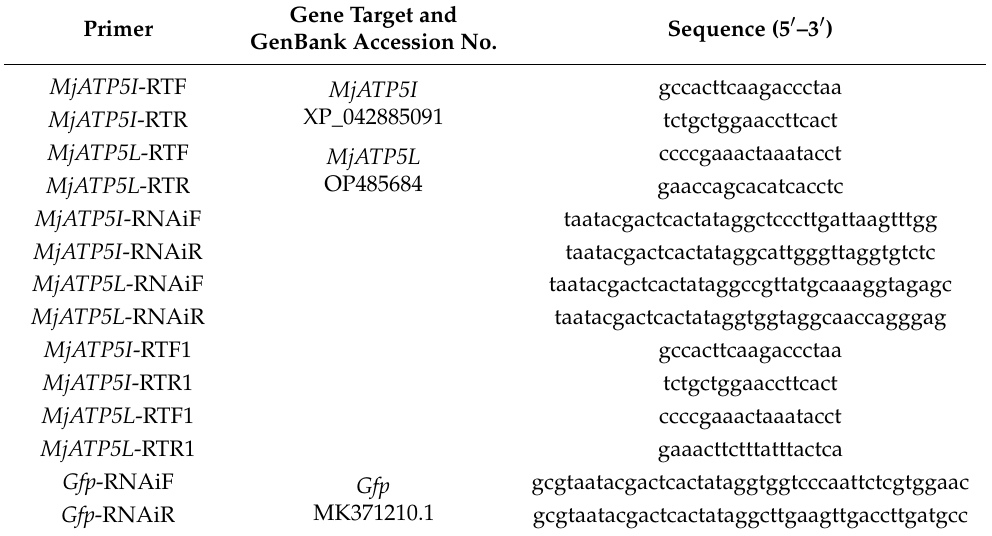
Table 1. Primers used in this